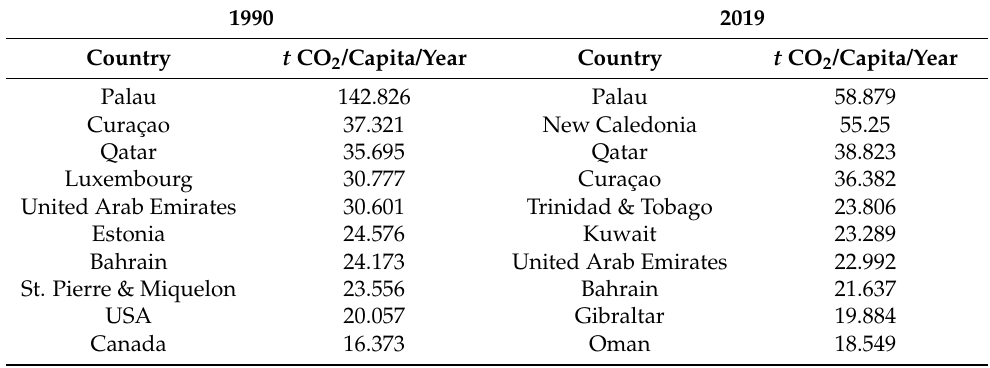
Table 5. Ten countries with the worst values of emissions per capita in 1990 and 2019. Own elaboration. 1990